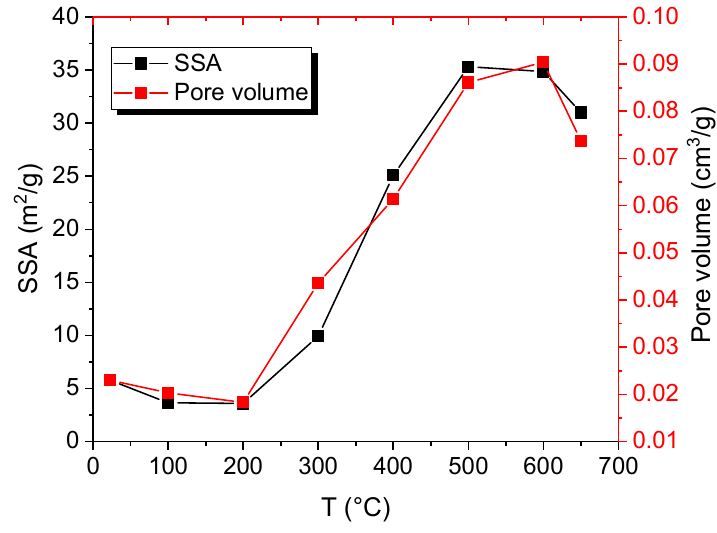
Figure 4. Specific surface area (SSA) and pore volume curve with varying temperature by LPNA.